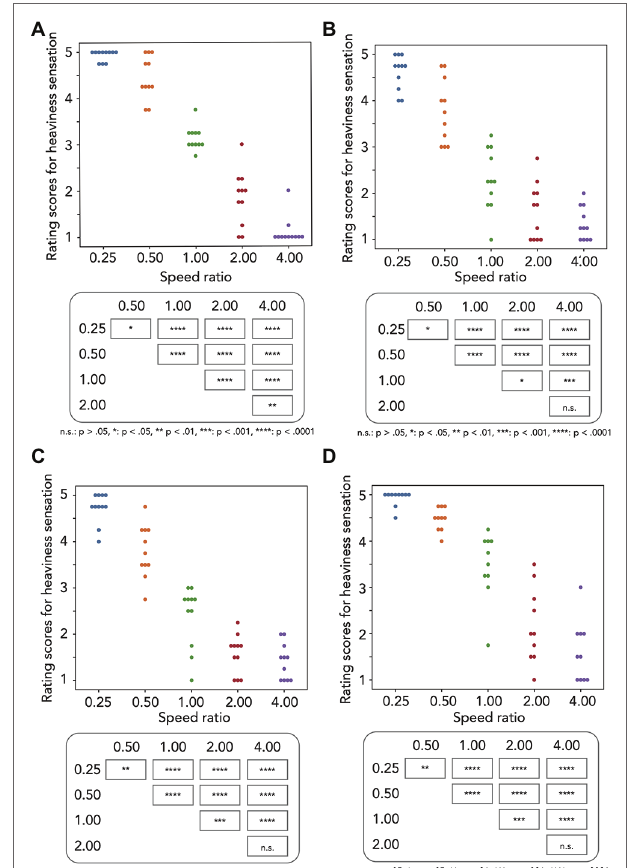
FIGURE 2 | Experimental results. Each graph in the top panel plots the rating scores for heaviness sensation as a function of speed ratio in (A) Experiment 1 ( N = 11), (B) Experiment 2 ( N = 11), (C) Experiment 3 ( N = 11), and (D) Experiment 4 ( N = 10). Each table in the bottom panel indicates the significance level for the multiple comparison based on the significant main effect.